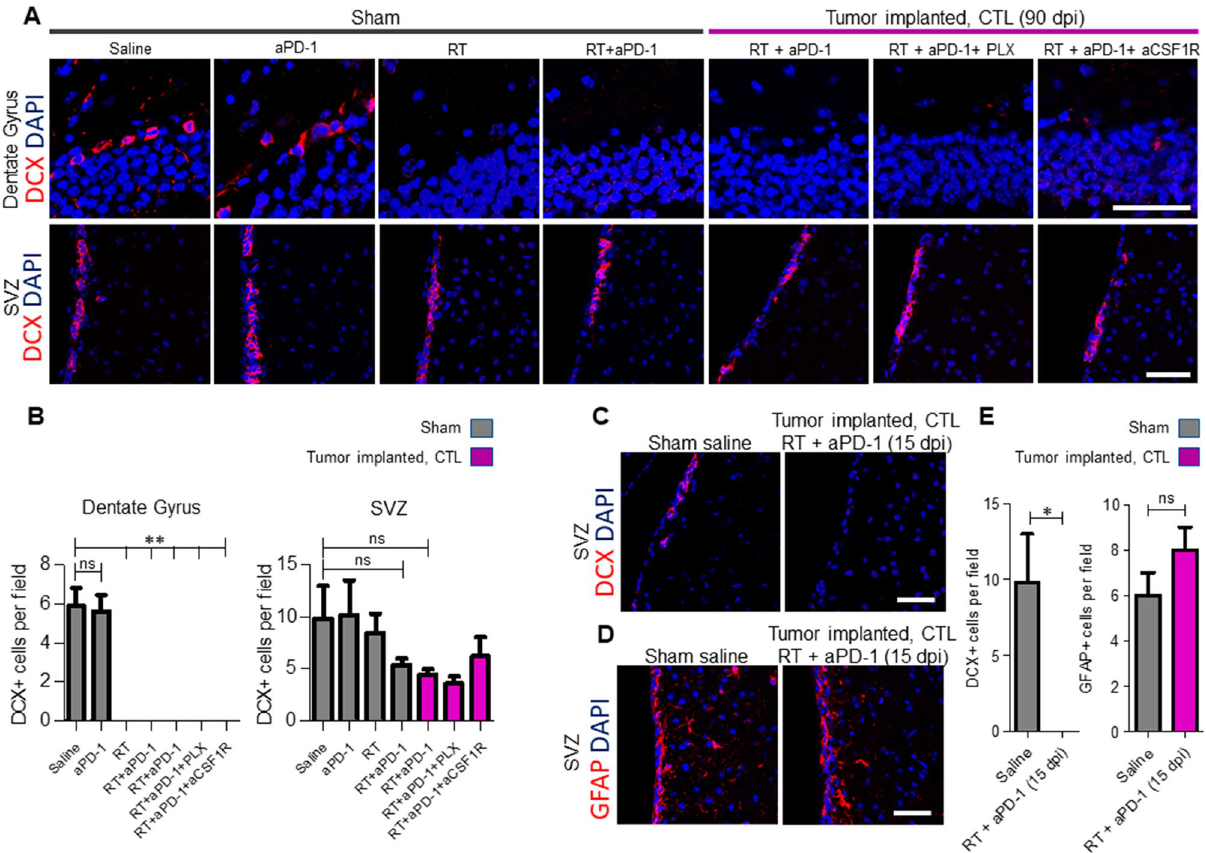
Figure 3. Long-term impact of whole-brain irradiations on neurogenesis in the subventricular zone (SVZ) and subgranular zone (SGZ). ( A ) Representative confocal micrographs of the dentate gyrus and the lateral ventricle stained for DCX in sham operated mice and tumor implanted mice for the indicated experimental groups. Samples were collected at 90 dpi and images taken from the contralateral hemisphere (CTL). Scale bar = 50 µm. ( B ) Quantification of DCX + cell number at 90 dpi in the SVZ and SGZ. n = 6 per treatment arm in sham mice and n = 6 RT + aPD-1 + saline, n = 3 RT + aPD-1 + PLX5622 and n = 3 RT + aPD-1 + aCSF1R in tumor implanted mice, ** P < 0.01 by ANOVA followed by Tukey’s post hoc t -test. ( C , D ) Representative coronal sections of the lateral ventricle stained for DCX and GFAP respectively from saline treated shams and an RT + aPD-1 treated tumor implanted mice at 15 dpi. Scale bar = 50 µm. ( E ) Quantification of DCX + and GFAP + cell number in the SVZ at 15 dpi for the experimental groups in panel C and D. n = 6 per group, * P < 0.05 by Student’s t